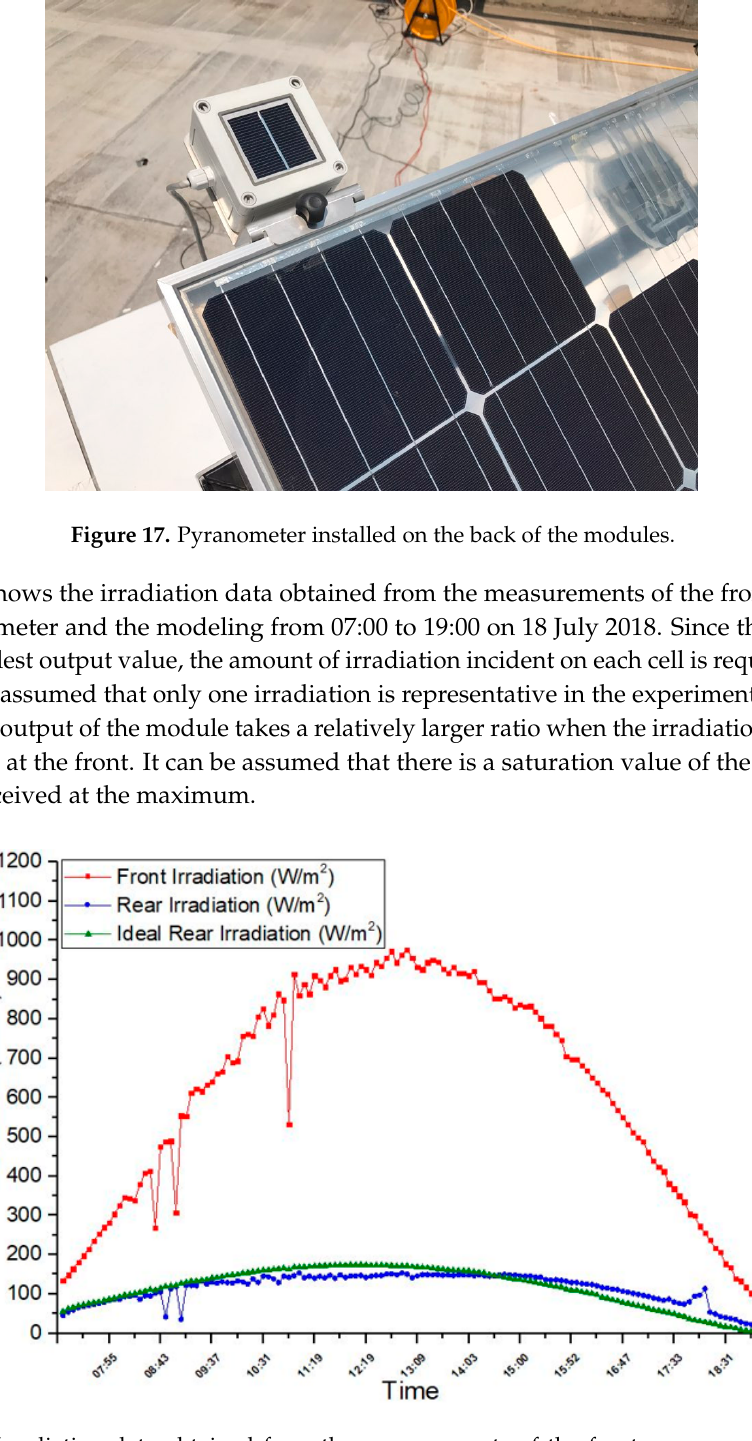
pyranometer and the modeling from 07:00 to 19:00 on 18 July 2018.